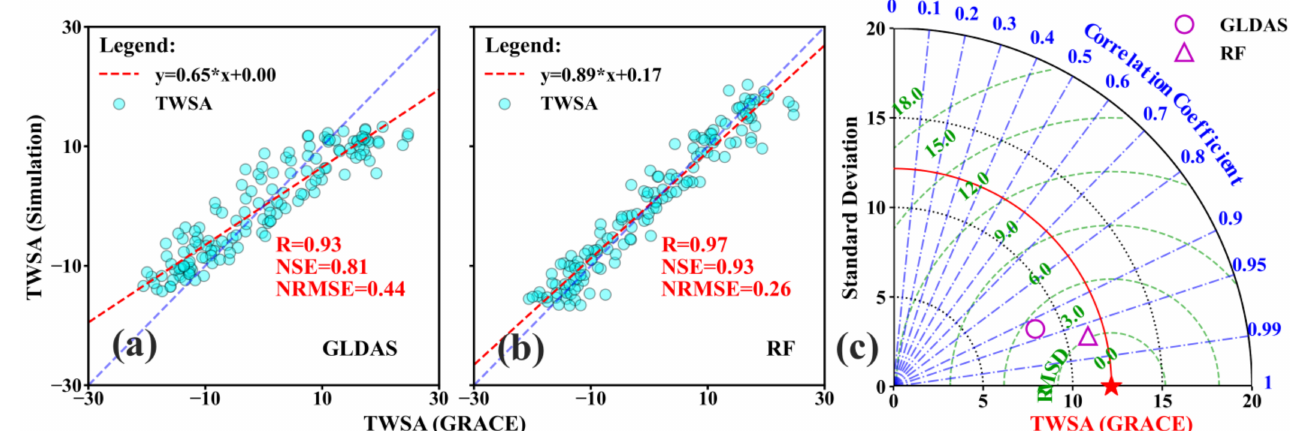
Figure 8. Performance comparison of the GRACE TWSA and simulated TWSA (GLDAS and RF-built TWSA) at the basin scale for 2003–2014. The 1:1 line is blue, and the fitted line is red. ( a ) Scatter plot of the GLDAS TWSA and GRACE TWSA time series; ( b ) Scatter plot of the RF-built TWSA and GRACE TWSA series; ( c ) Taylor diagram for comparing the GRACE TWSA data and the simulated TWSA